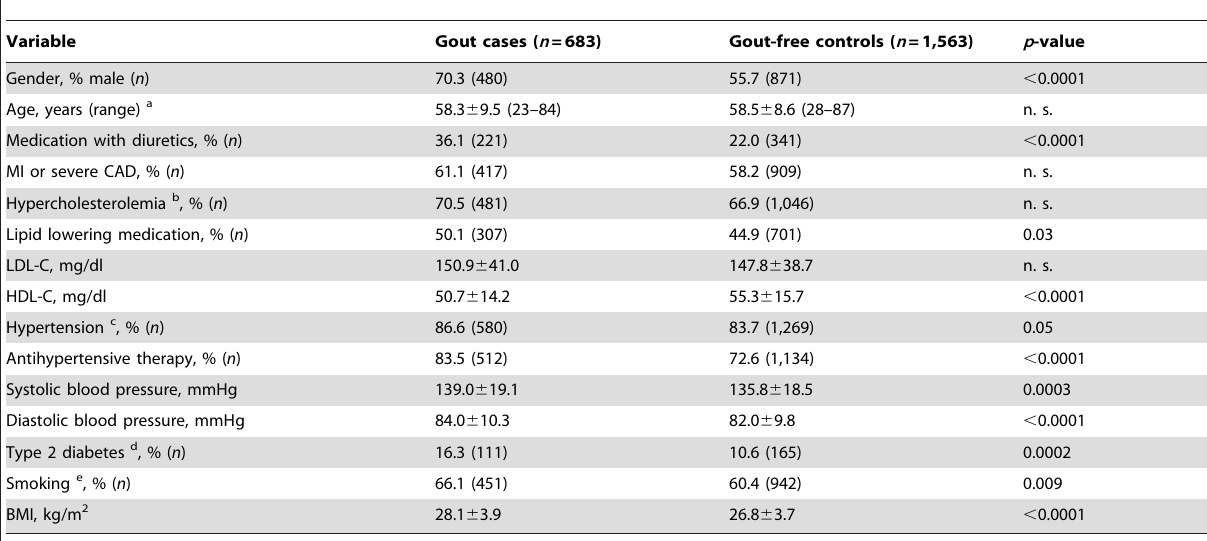
Table 1. Characteristics of gout case and control study sample.